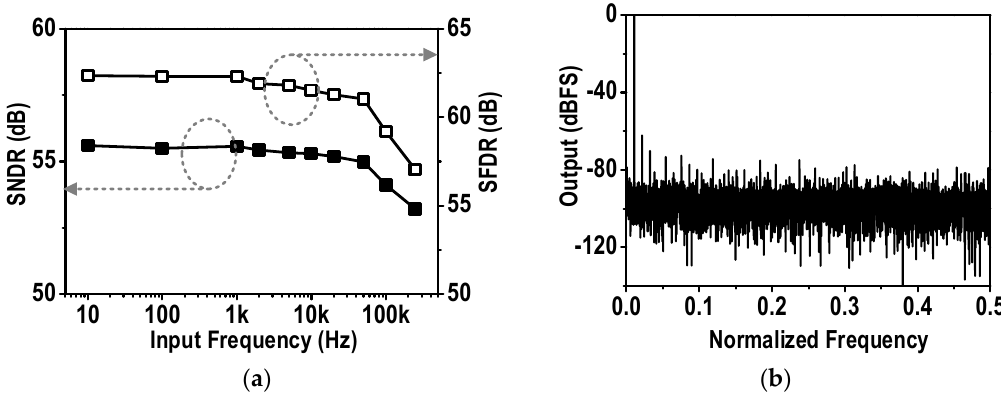
Figure 13. LNA noise characterization: ( a ) Input referred noise voltage spectrum from 0.4 Hz to 50 kHz; ( b ) Input referred transient noise voltage waveform.